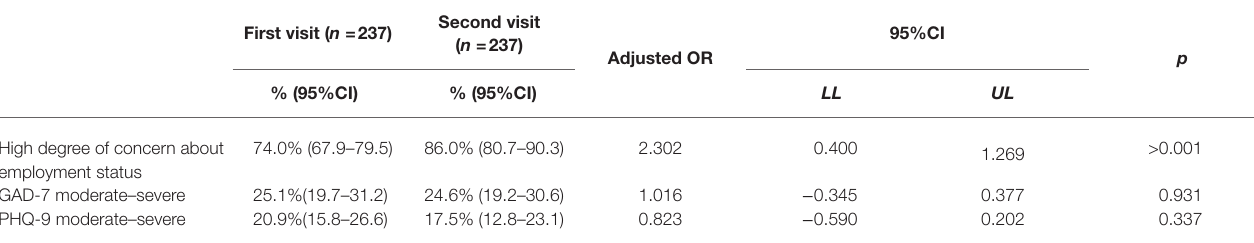
TABLE 3 | Evolution of high degree of concern about employment status (4 and 5), moderate–severe anxiety, and moderate–severe depression between March–April to October–December